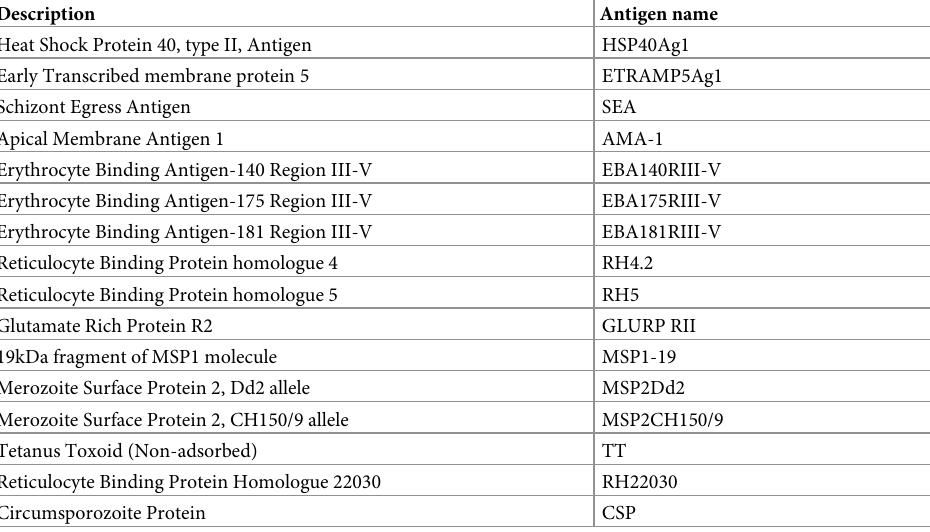
Table 1. Summary of the P . falciparum Blood stage specific